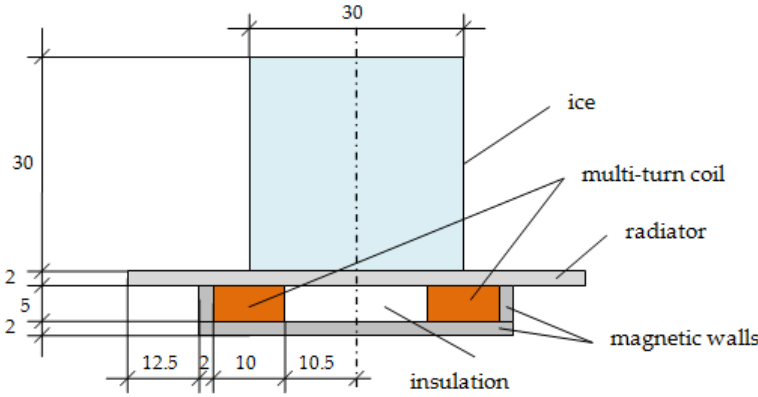
Figure 7. Geometry of IH coil with enclosure, radiator and ice on its surface (dimensions in milli- meters).